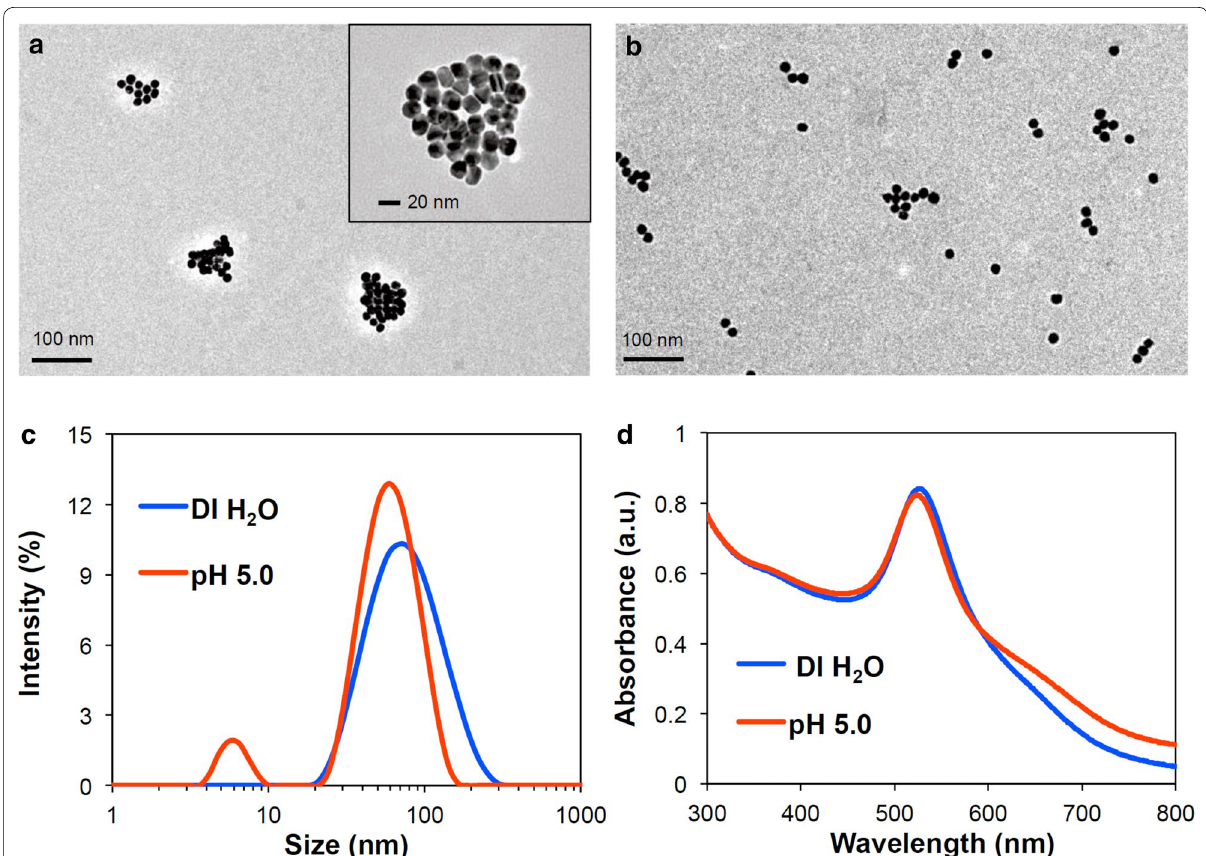
Fig. 3 Characterization of Au NCs. Acid‑responsive changes in size and morphology of Au NCs incubated in DI water and 100 mM acetate buffer (pH 5.0) at 37 °C for 2 h, confirmed by TEM ( a DI water; b pH 5.0), DLS ( c ), and UV–Vis spectra ( d